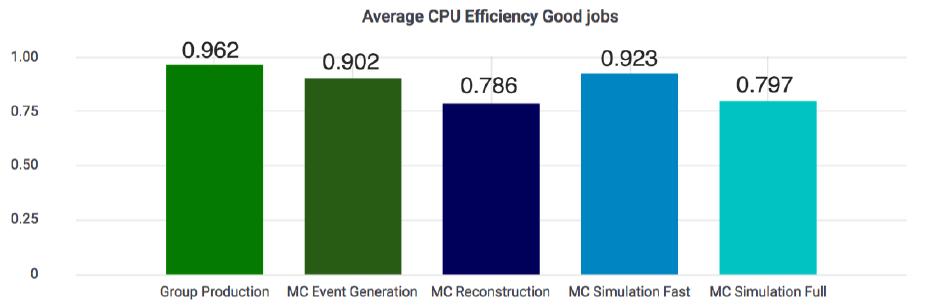
Figure 9: Average CPU e ffi ciency sorted by job type for the UiO Openstack site UIO_CLOUD running in the ARC native mode. The plot shows the e ffi ency averaged over a period of 2